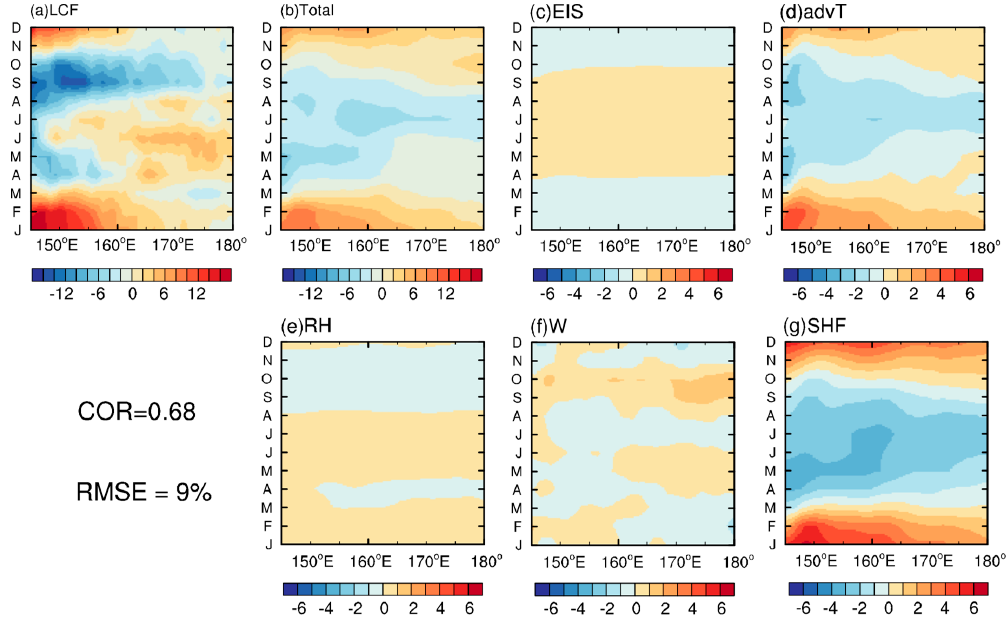
Figure 5. ( a ) Same as Figure 3a, except that the annual-mean LCF (%) has been removed. ( b ) Same as ( a ), except for the corresponding LCF (%) predicted by the multiple linear regression model. The correlation and root mean square error (RMSE) between ( a , b ) are shown below ( a ). ( c – g ) Same as ( b ), except for individual contributions from EIS, advT, 700-hPa RH, 700-hPa subsidence, and SHF to ( b ), respectively.